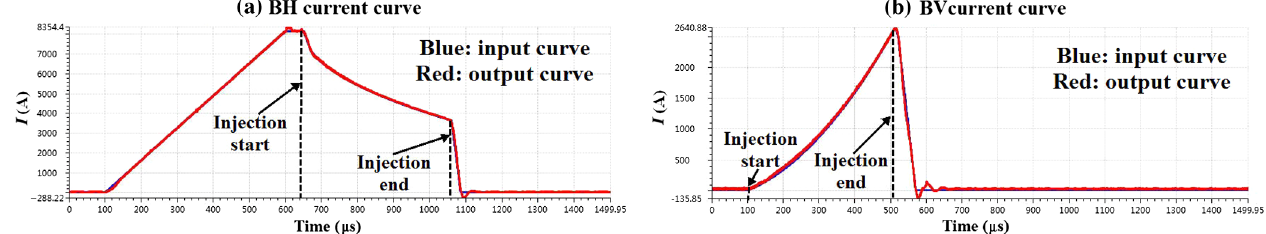
FIG. 7. Comparison of the input and output pulse current curves for the correlated painting method.